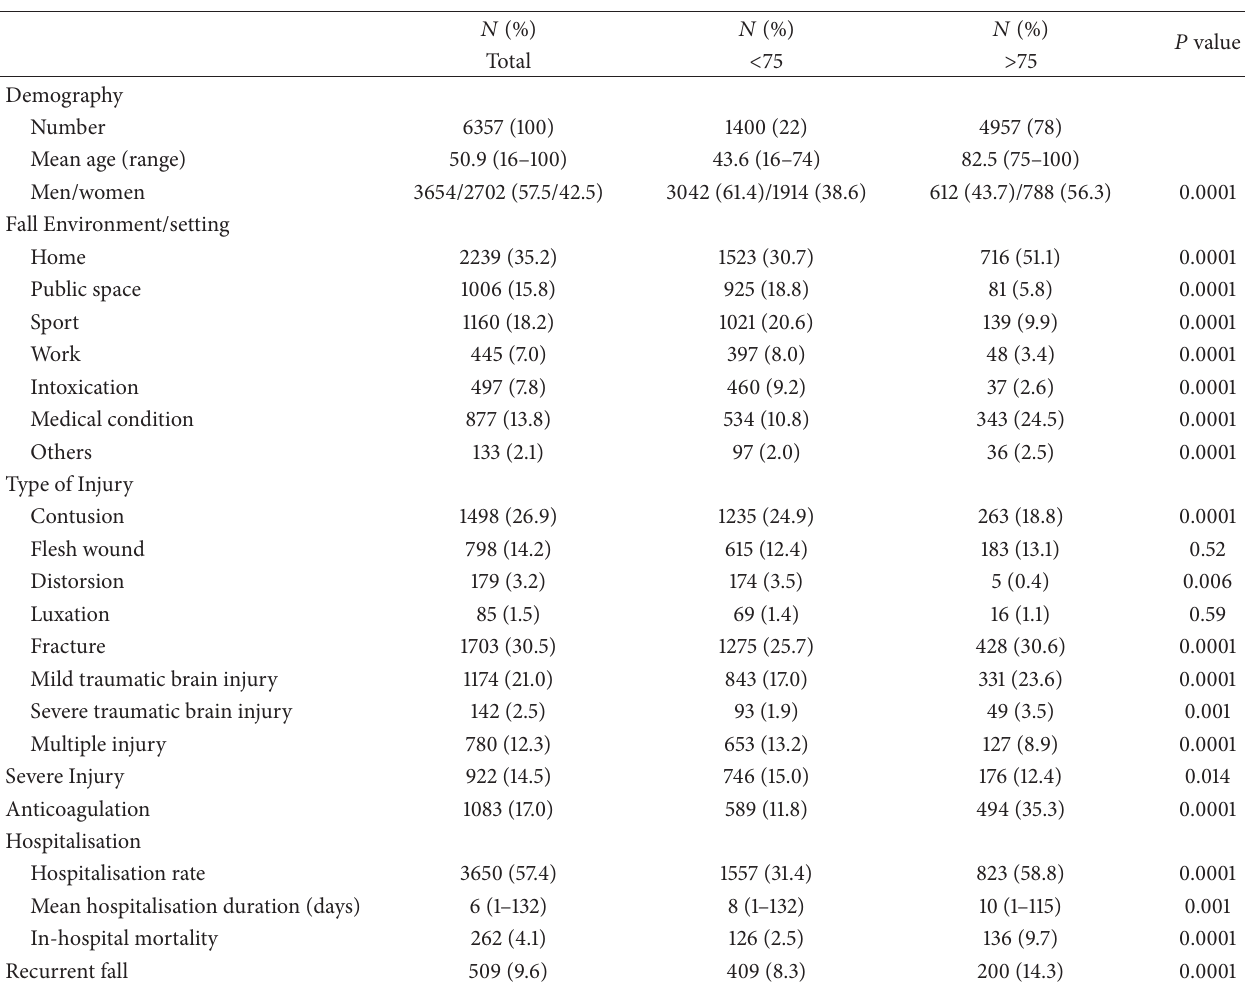
Table 1: Patients